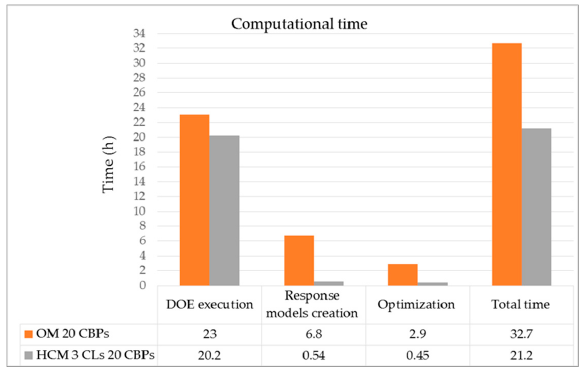
Figure 10. Comparison of the computational time for the applied ICESM calibration at four full ‐ load operating points and 20 CBPs with two different approaches, one ‐ step optimization method (OM) and HCM.